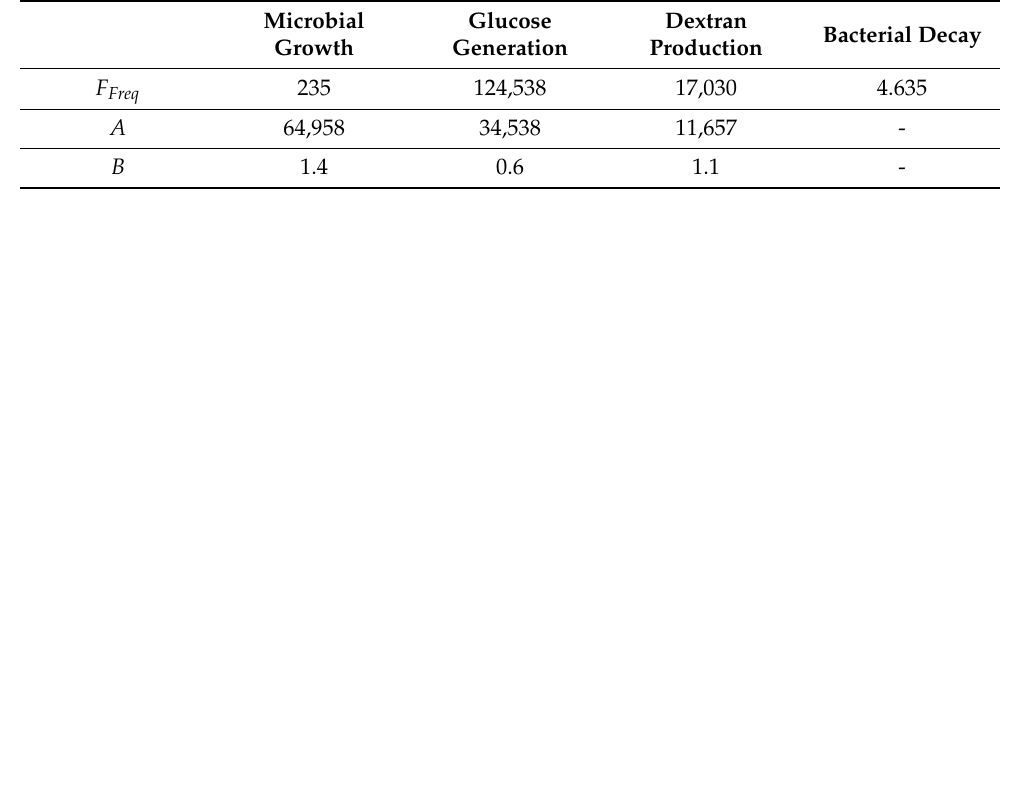
Table 1. Batch model for bacterial growth and dextran